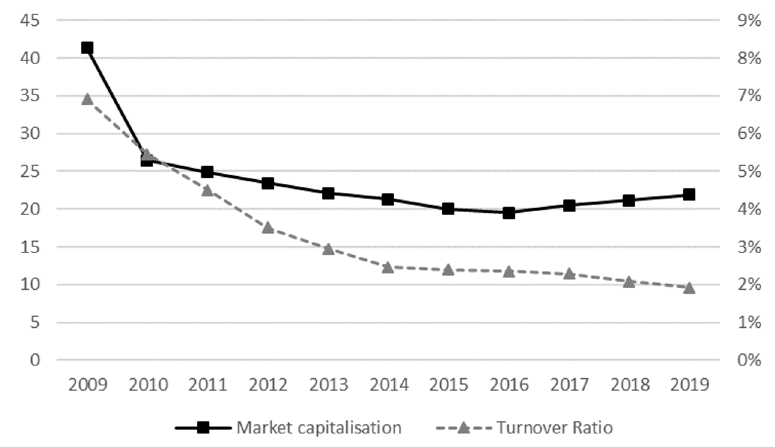
Figure 1. Croatian stock market turnover ratio and market capitalization (three-year moving averages, market capitalization in billions of USD, the turnover ratio in %). Data from the World Bank and the Zagreb Stock Exchange.